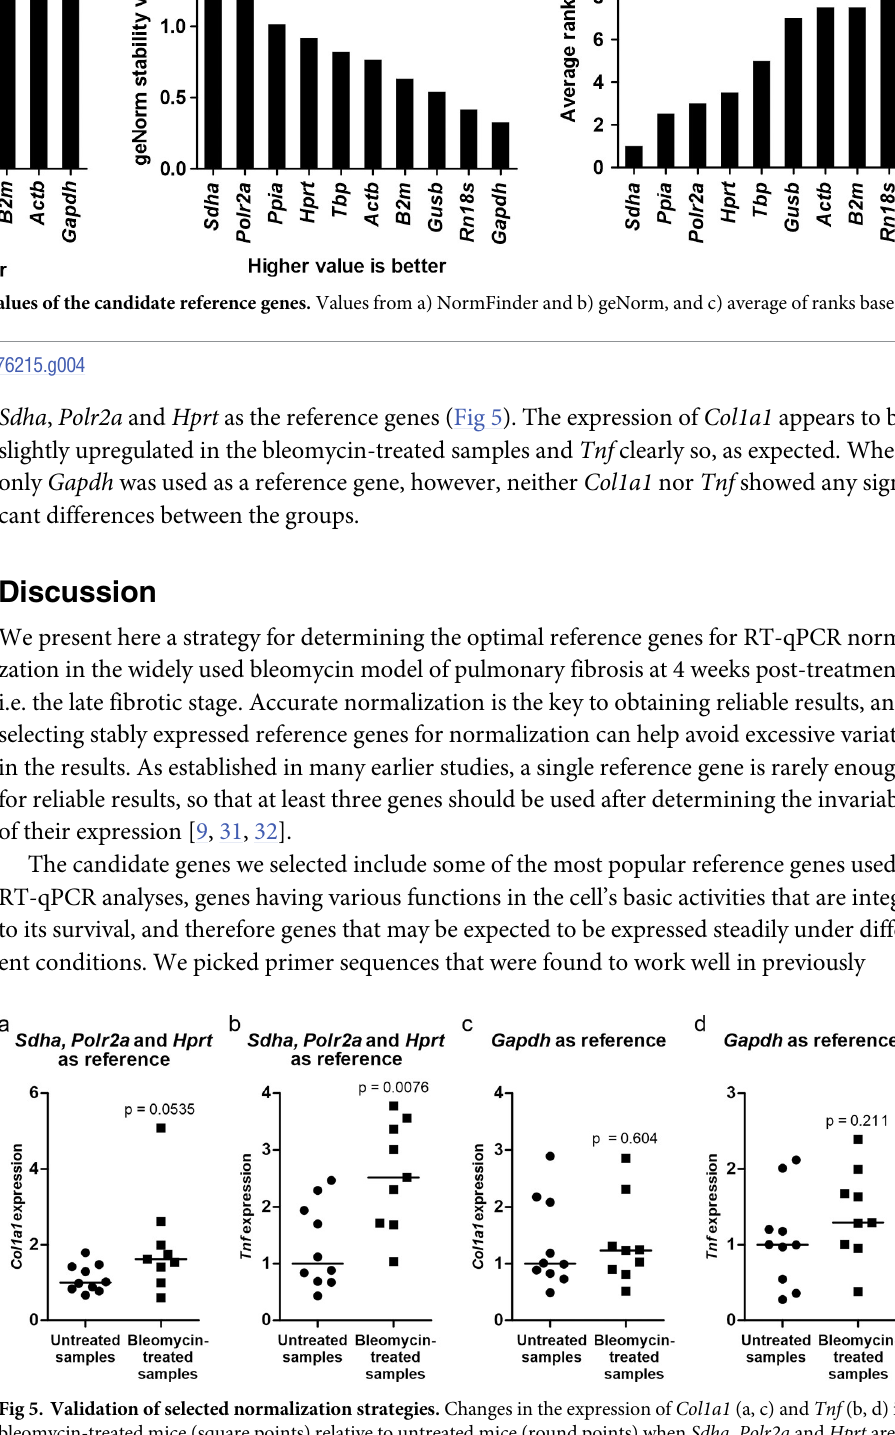
PLOS ONE | https://doi.org/10.1371/journal.pone.0276215 October 17,